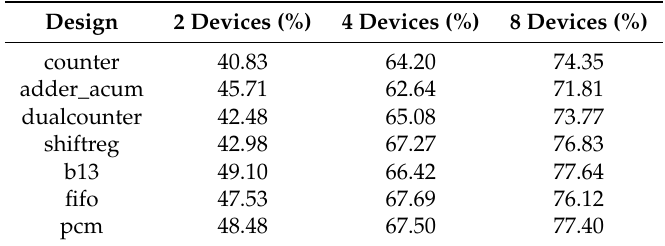
Table 7. Execution time